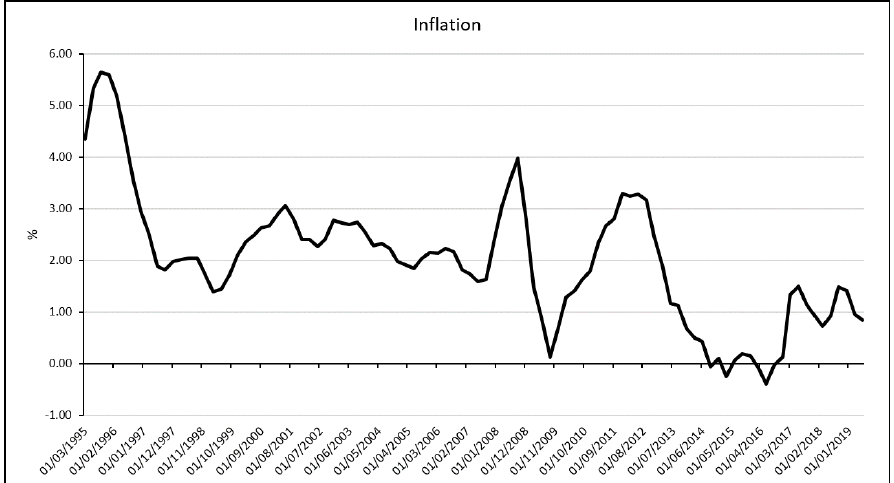
Figure 2. Italian Inflation rate from the period of 1995:Q1 to 2019:Q2 (data source: Eurostat, 2019, ‘own